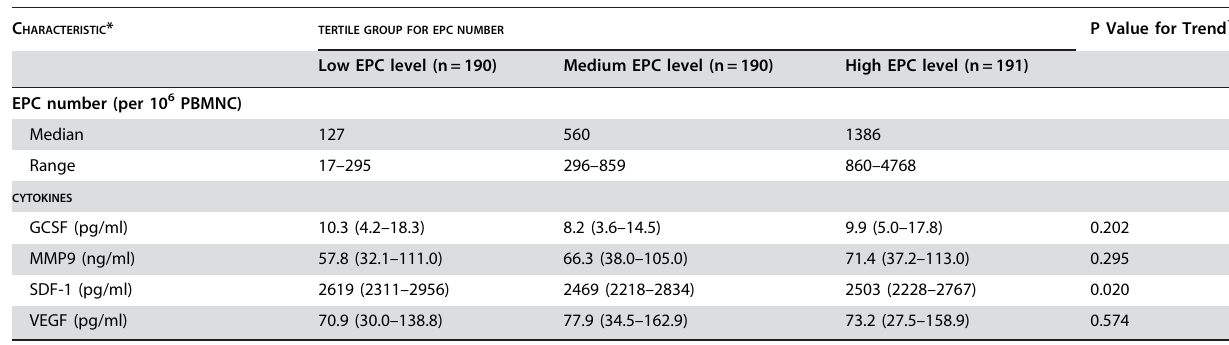
Table 3. Association of cytokines levels with EPC number (n=571) .. ... .... ... ... .... ... ... .... ... ... .... ... ... .... ... ... .... ... ... .... ... ... .... ... ... .... ... ... .... ... ... .... ... ... .... ... ... .... ... ... .... ... ... . C HARACTERISTIC